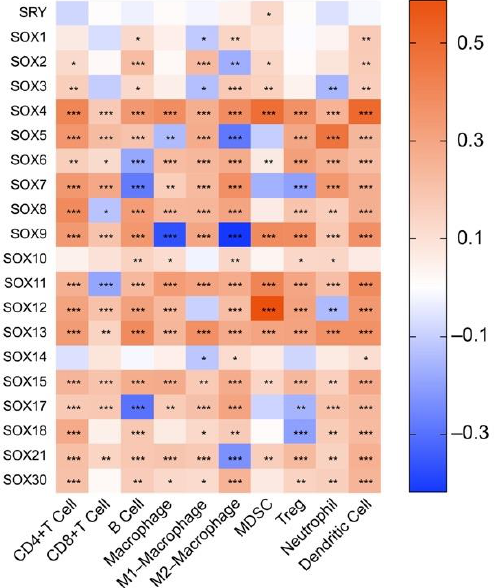
Figure 3. The association heatmaps between SOX transcription factor expression and immune cell infiltration in hepatocellular carcinoma. Red indicates positive correlation, and blue indicates negative correlation. The darker the color, the stronger the correlation. The data was analyzed by the TIMER2. * p < 0.05, ** p < 0.01, *** p < 0.001.